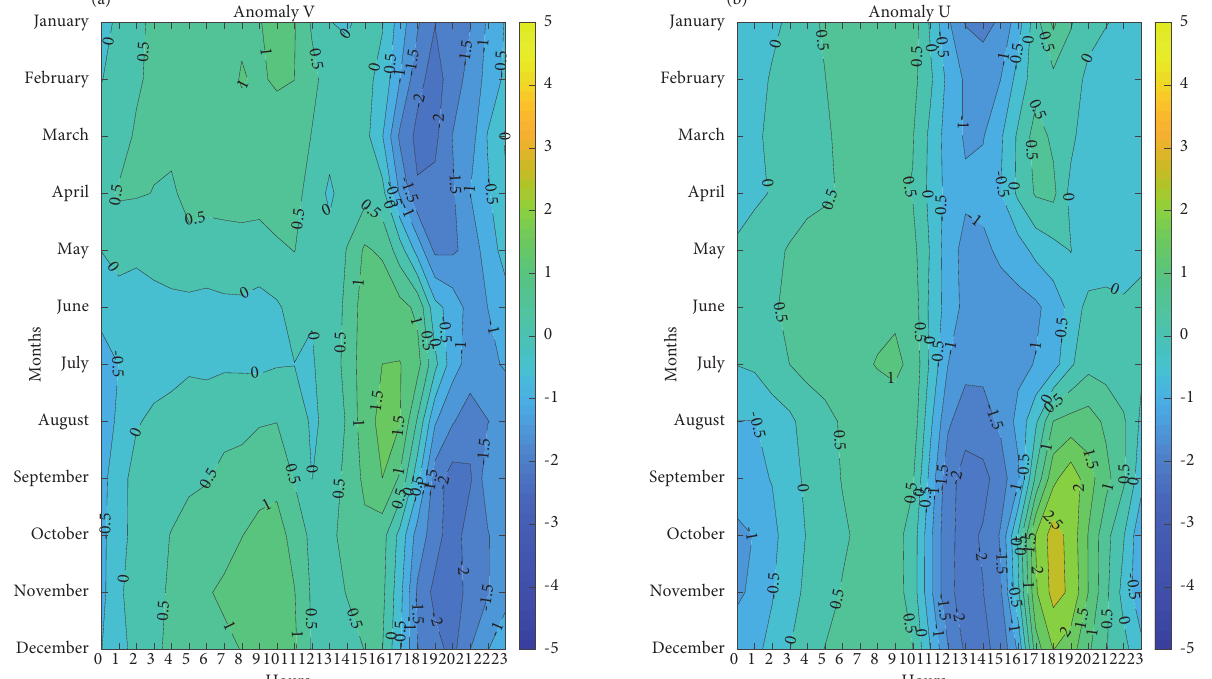
Figure 12. Monthly hourly anomaly for meridional (a) and zonal (b) wind component from 2003 to 2013 in